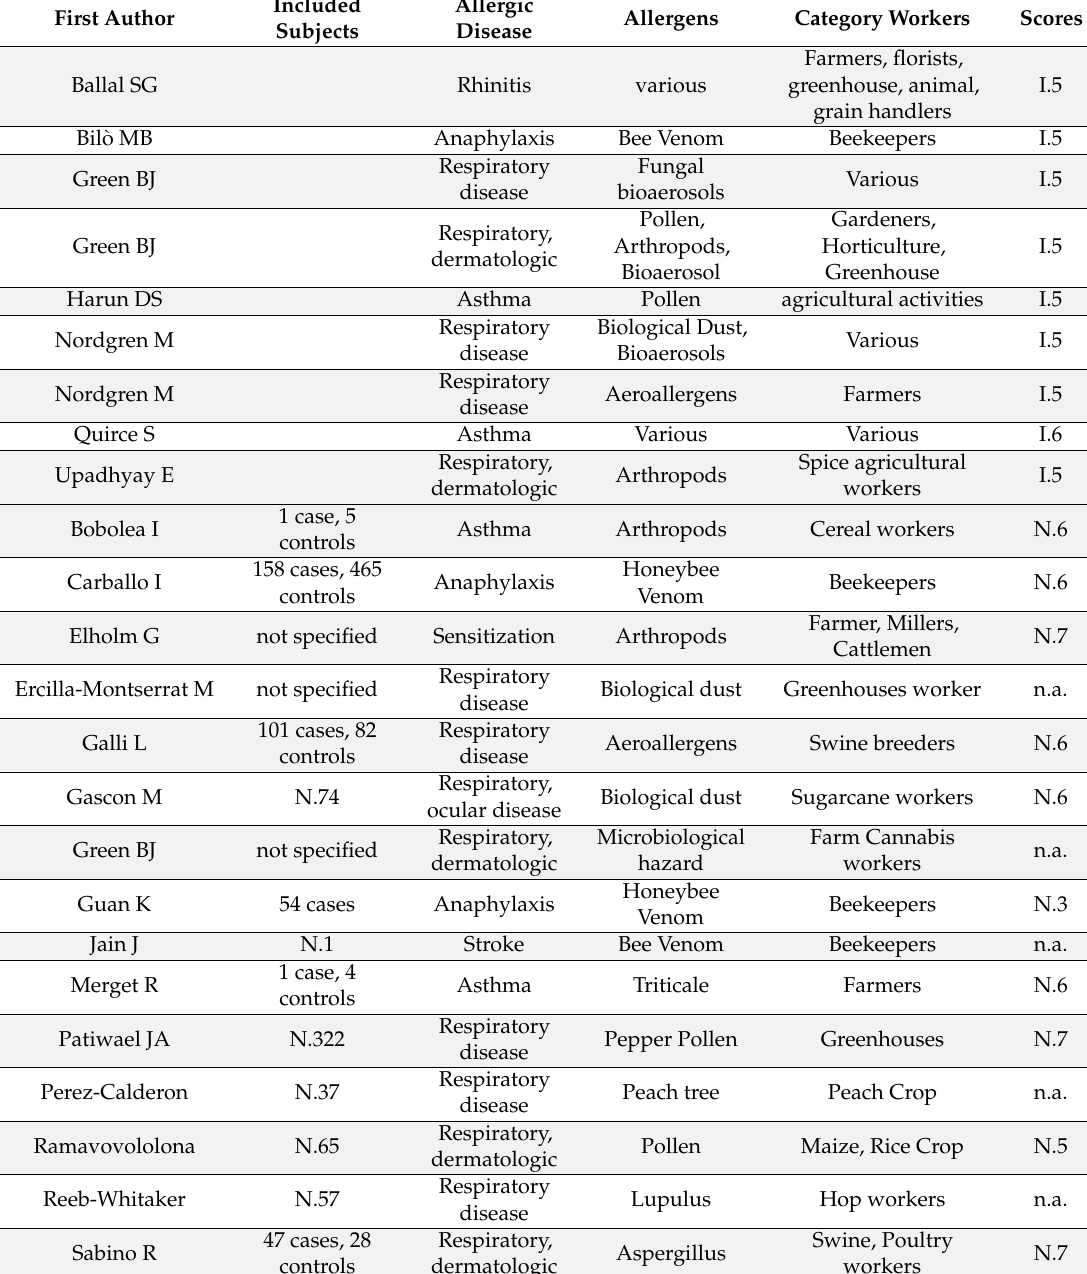
Table 2. Reviews and cohort studies, case-control, case series, case report, pilot study, experimental study, with their relative